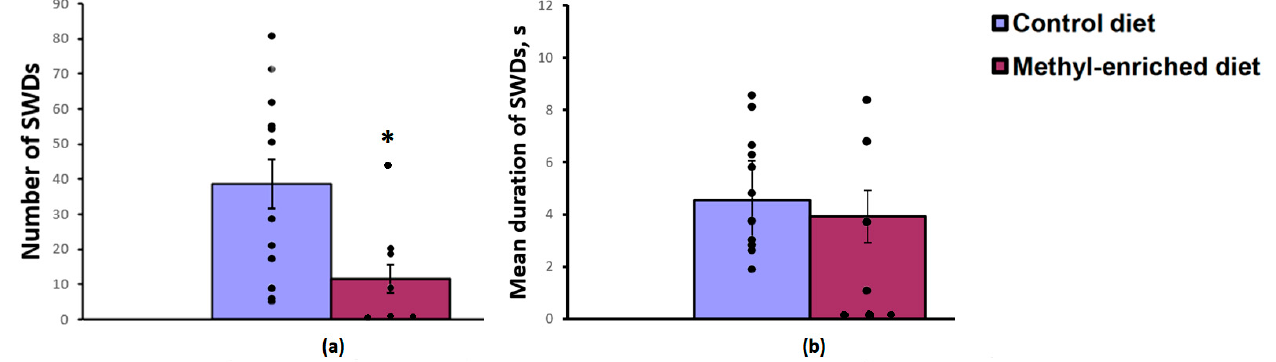
Figure 1. Number ( a ) and mean duration ( b ) of SWDs in adult offspring of WAG/Rij rats born to mothers fed a methyl-enriched ( n = 8) or control diet ( n = 13). Data are the mean ± S.E.M. The individual data points are displayed in bar graphs to show within-group variability. *— p < 0.05 compared with the corresponding values in the control group.